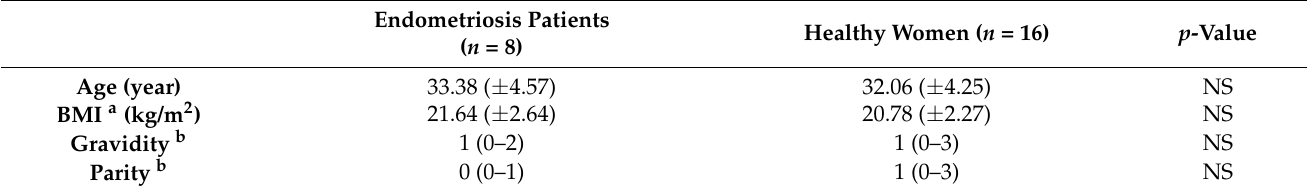
Table 1. Clinical characteristics of patients with endometriosis and healthy women.